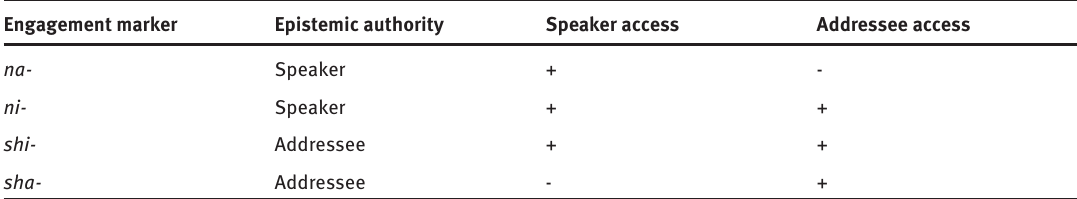
Table 1: Engagement values for na-/ni-/shi-/sha according to Figure 3.